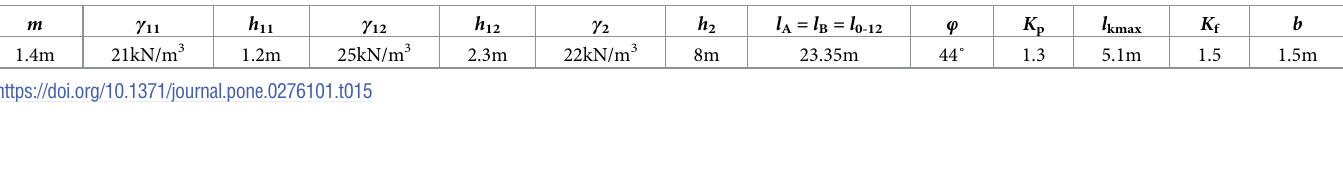
Table 15. Calculation parameters of MSSC in No.5 coal